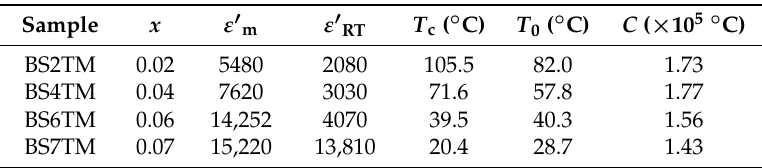
Table 2. Dielectric parameters for BSTM ceramics.